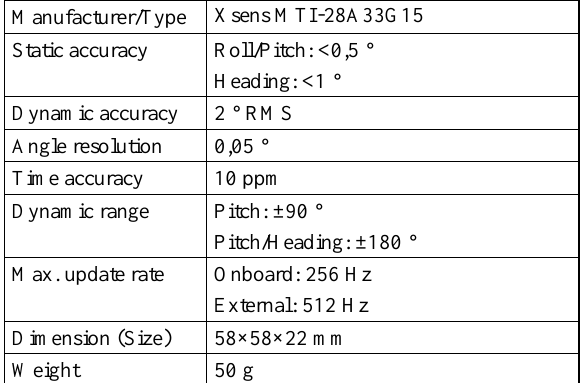
Table 3: IMU technical